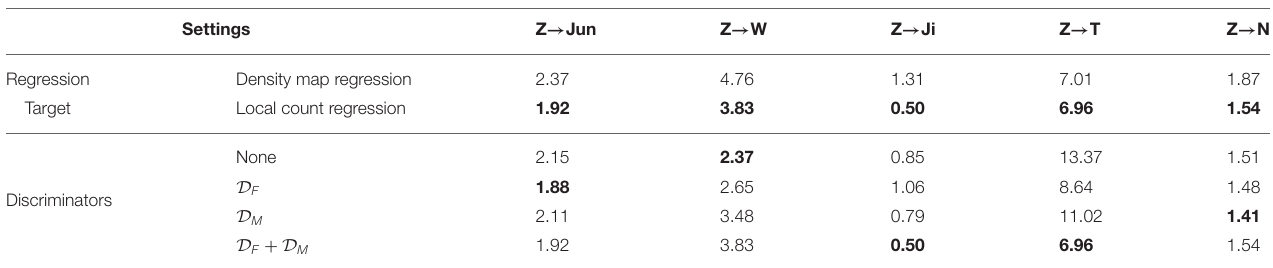
TABLE 5 | Ablation study on regression targets and discriminator configurations